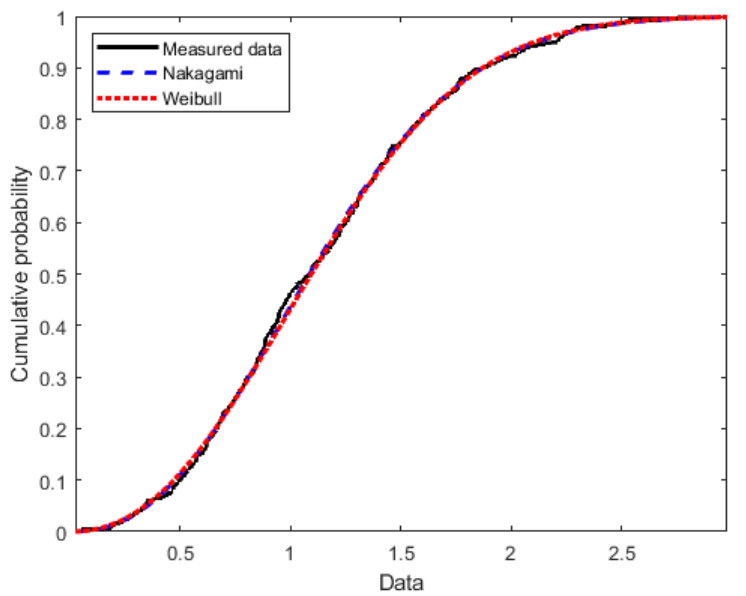
Figure 15. Cumulative distribution functions fitting fast variations within the large lab at 5.8 GHz in NLoS conditions.